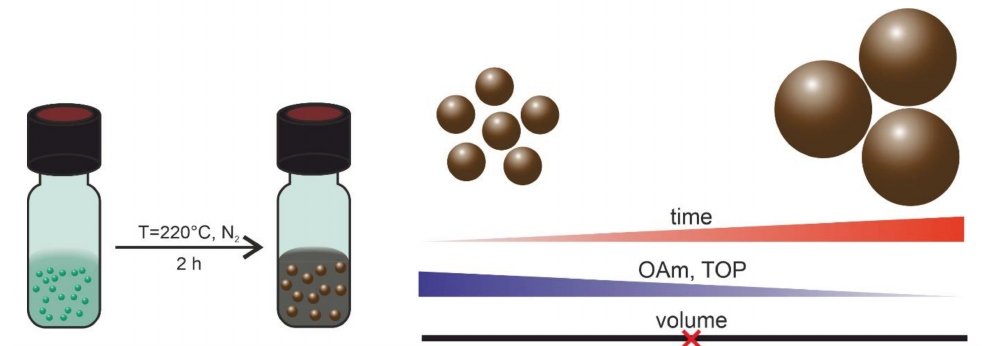
Figure S1: SAXS data of particles after di ff erent reaction times with corresponding Schulz–Zimm-fit (red lines), Figure S2: Influence of the OAm:Ni ratio on the particle size of nickel nanoparticles. T = 220 ◦ C, t = 2 h, [Ni] = 50 mmol / L, TOP = 1.5 eq. SAXS data with corresponding Schulz–Zimm fit (red lines), Figure S3: SAXS data with corresponding Schulz–Zimm fit (red lines). Influence of TOP:Ni ratio on the nanoparticle size. T = 220 ◦ C, t = 2 h, [Ni] = 50 mmol / L (left) and [Ni] = 25 mmol / L (right), pure OAm, Figure S4: SAXS data with corresponding Schulz–Zimm fit (red lines). Volume-independent nanoparticle size. T = 220 ◦ C, t = 2 h, [Ni] = 50 mmol / L, TOP = 1.5 eq, pure OAm, Figure S5: STEM images of NiNPs after synthesis (left) and after nine weeks of storage in air (right), and selected regions (white rectangle) used for EDS